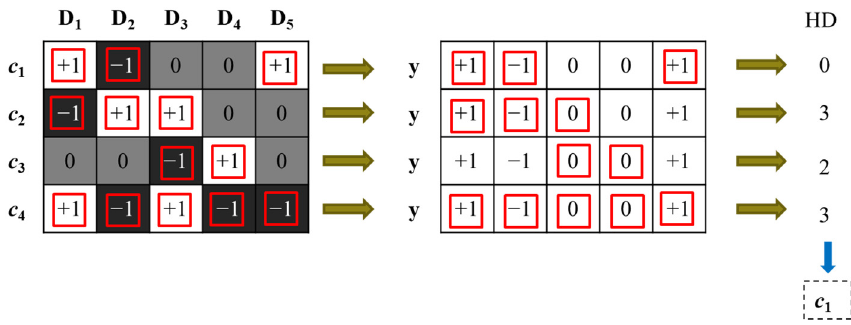
Figure 8. The output code of test sample supervised by SM-ECOC-V2 algorithm in the decoding process.